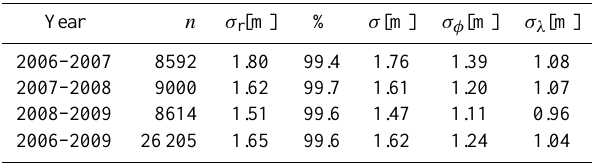
Table 3. Comparison between GPS and DGPS measurements at NBRef. 1φ and 1λ are the differences in the latitudinal and lon- gitudinal direction, respectively, where negative values denote the positions to the south and/or west of NBRef. 1 total is the com- bined distance between the instruments, Dir is the direction from the GPS towards the DGPS location, and H gps and H dgps refer to elevation determined by the GPS and DGPS,